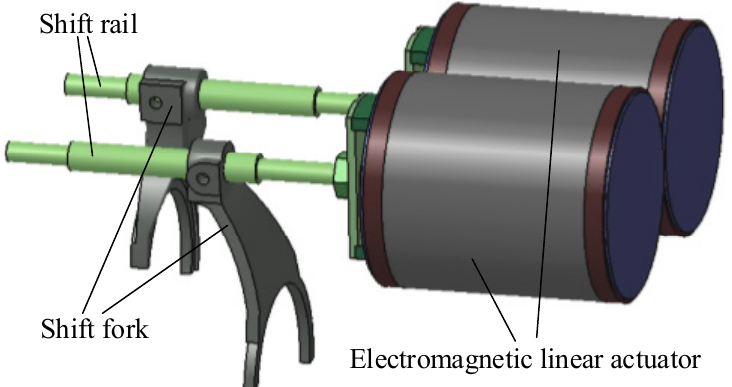
Figure 1. The direct drive gearshift system.